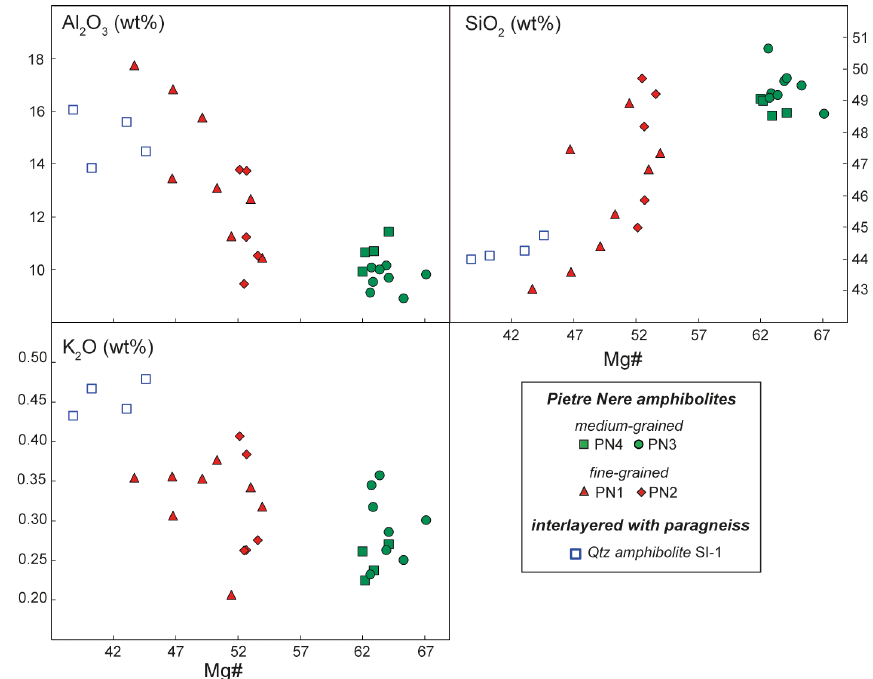
Figure 7. Variation of Al 2 O 3 (wt%), SiO 2 (wt%) and K 2 O (wt%) vs. Mg# in hornblende.